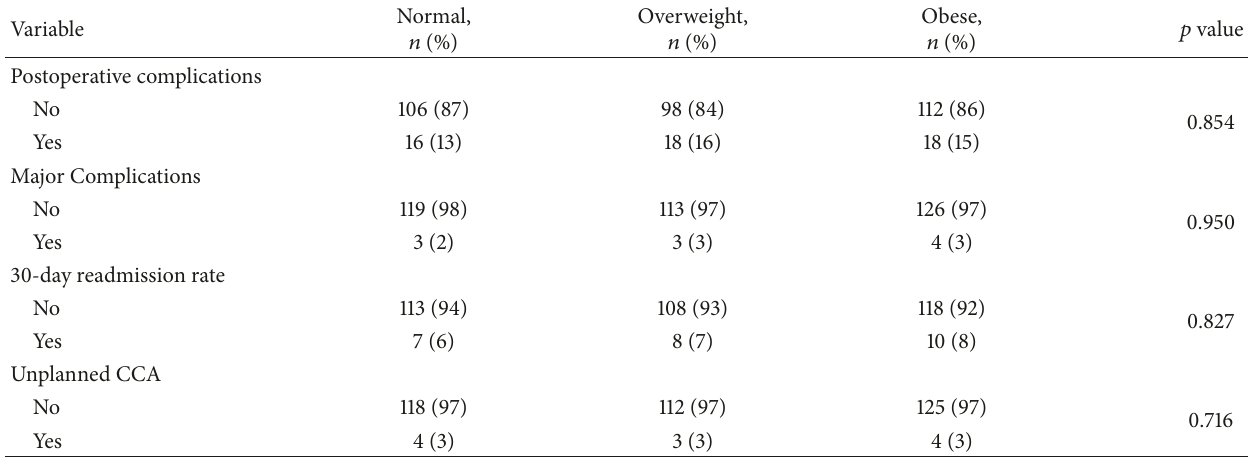
Table 3: Postoperative outcomes by